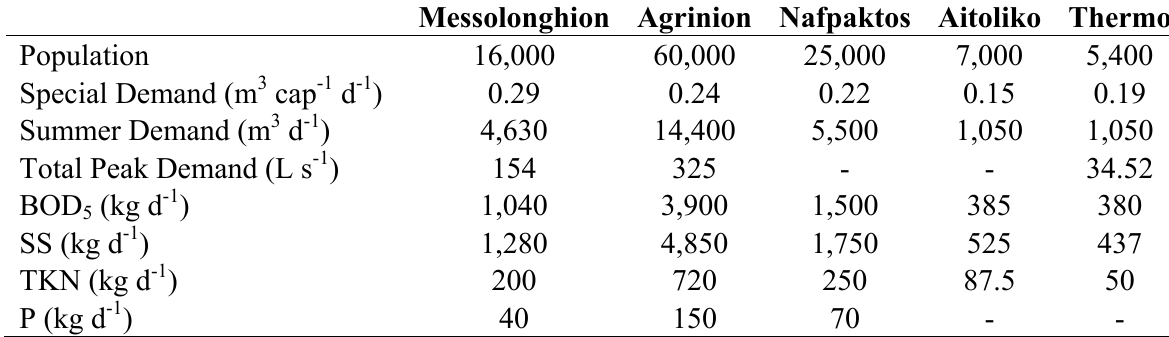
Table 1. Wastewater treatment plants of Aitoloakarnanias